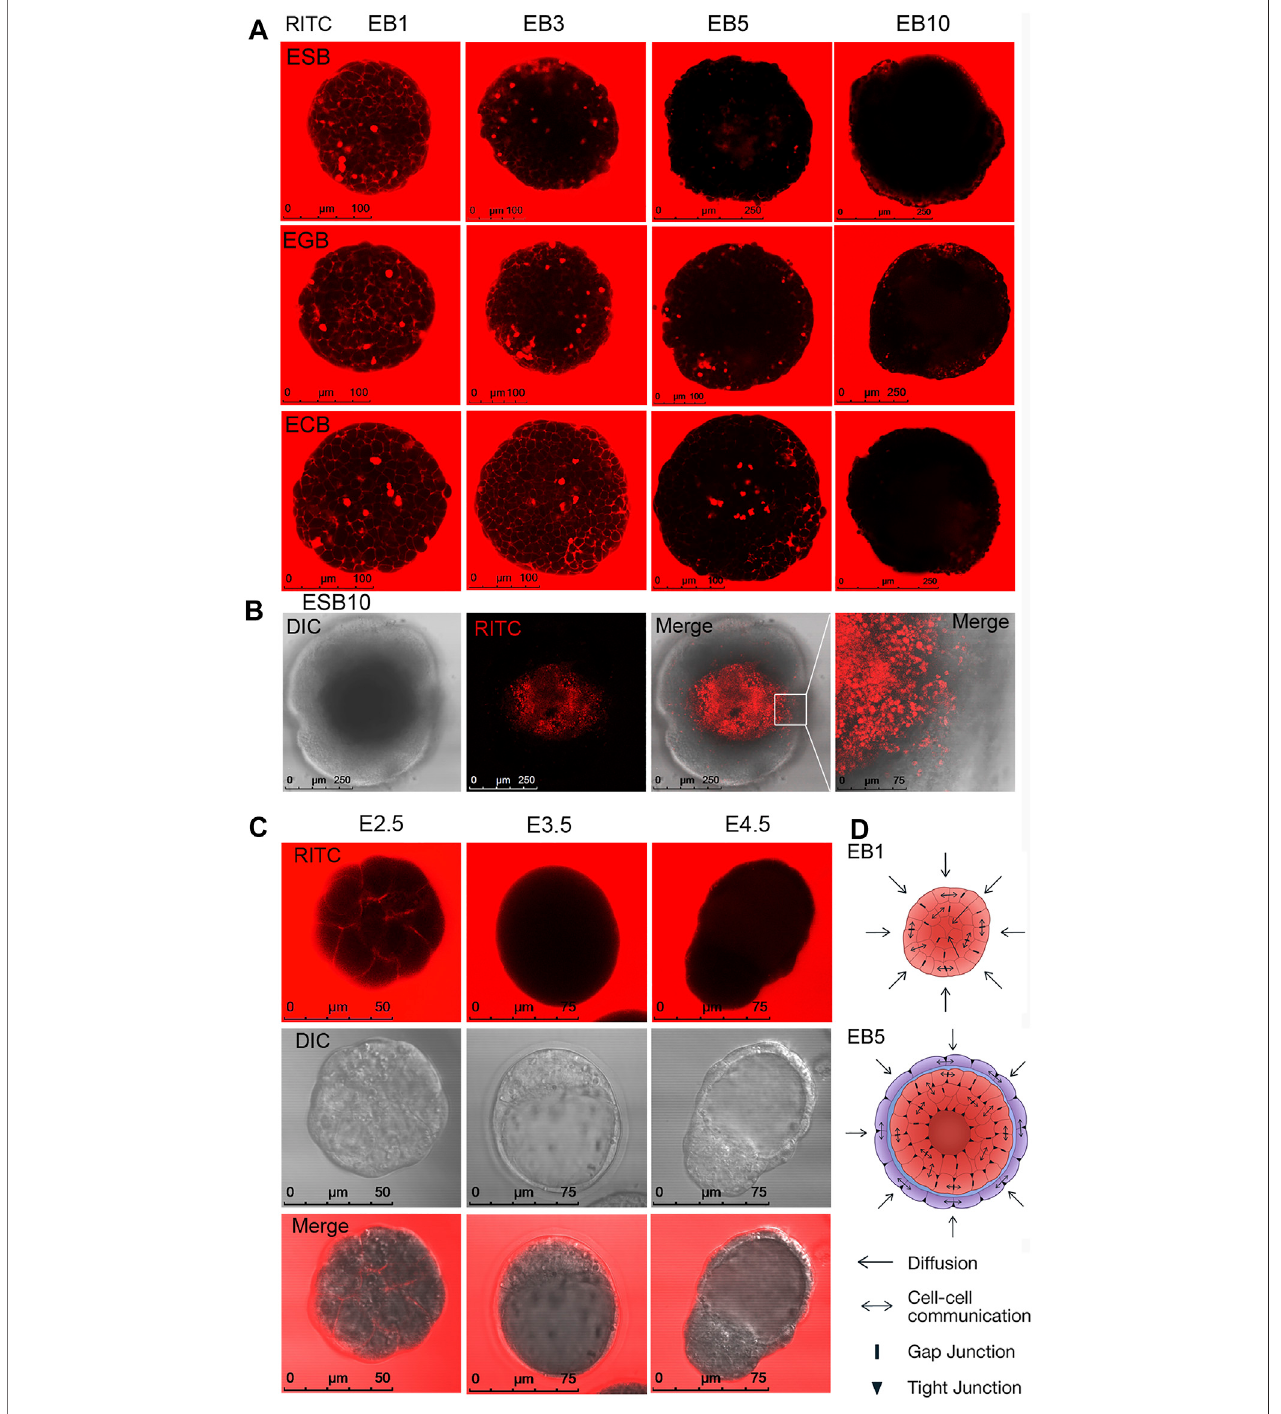
FIGURE 5 | Cellular communications and small molecule diffusion in differentiating EBs and early embryos. (A) Representative images of live cell analysis of RITC diffusion in ESB, EGBs, and ECBs at the EB1-EB10 stages. Free RITC diffusion was detected in the intercellular space ofthe outer and inner cell layers of EB1and EB3, partial diffusion in the intercellular space of EB5, and no free diffusion in EB10. (B) No free diffusion was detected after the RITC injection into the internal cavity of EB10 (only dead cells staining). (C) Free RITC diffusion was detected in the intercellular space between the blastomeres of the E2.5 morula but not in the E3.5 and E4.5 blastocysts. (D) The scheme of cellular communications and the diffusion of substances from the external environment modulated by intercellular contacts in EB1 and EB5. Epi-l — red, ExEn — purple, basement membrane — blue.